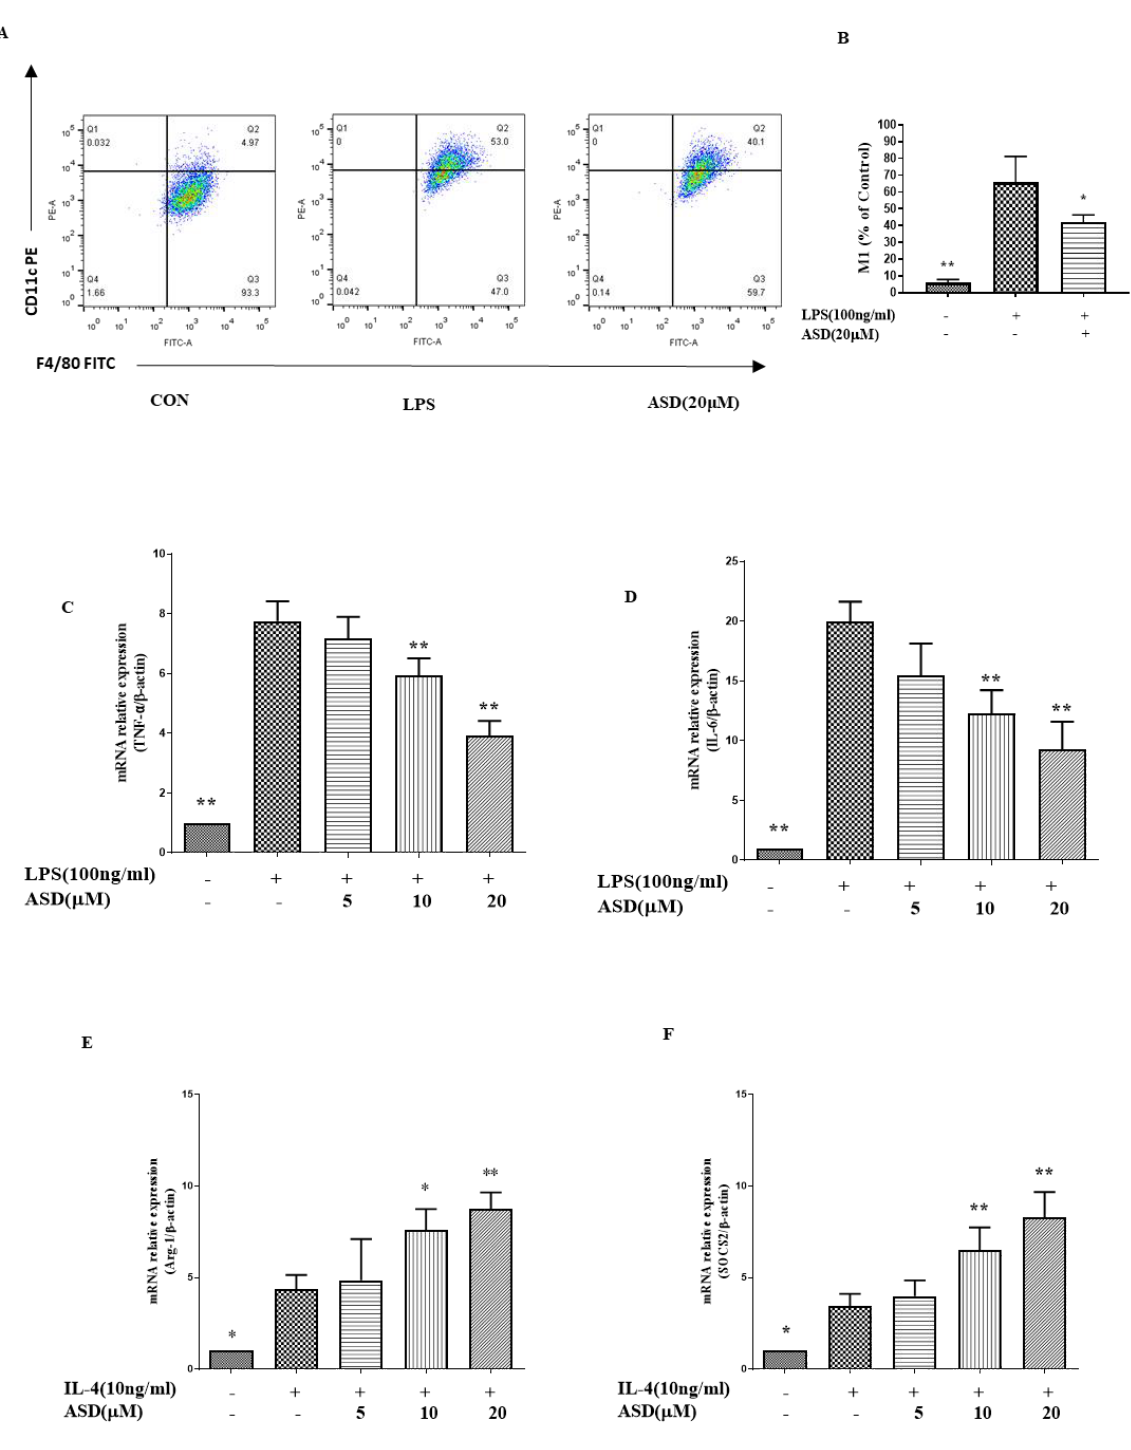
Figure 3. Pharmacodynamic effect on the expression of M1, TNF- α , IL-6, Arg-1, and SOCS2. The M1 markers ( A , B ) were detected following the kits’ methods. Gene expression levels of TNF- α ( C ), IL-6 ( D ), Arg-1 ( E ), and SOCS2 ( F ). The data are shown as the average value ± SD, * p < 0.05, vs. LPS-treated cells, ** p < 0.01, vs. LPS-treated cells ( B , D ). * p < 0.05, vs. IL-4-treated cells, ** p < 0.01, vs. IL-4-treated cells ( E , F ).